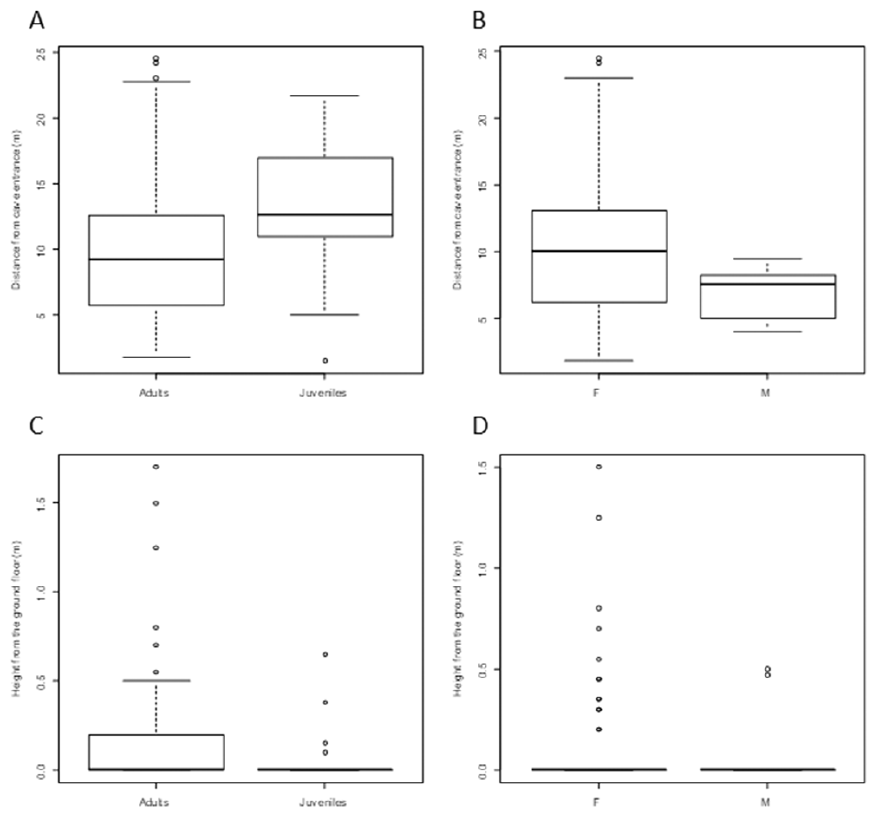
Figure 3. Boxplots indicating differences in the use of cave spaces. Difference between A age classes (Adults/ Juveniles) and B adult sexes (Females/Males) in the use of the subterranean surface area; dif- ferences between C age classes and D adult sexes in the use of cave walls. Diagonal bar inside the box represents the